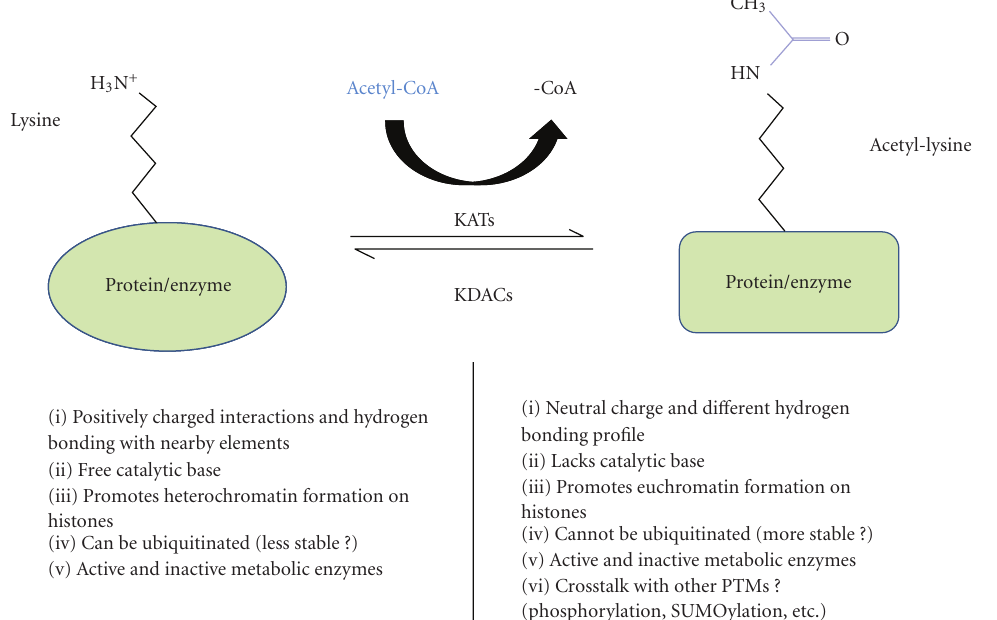
Figure 2: Changes in protein function and stability known to be associated with lysine acetylation. KATs: lysine acetyltransferases, KDACs: lysine